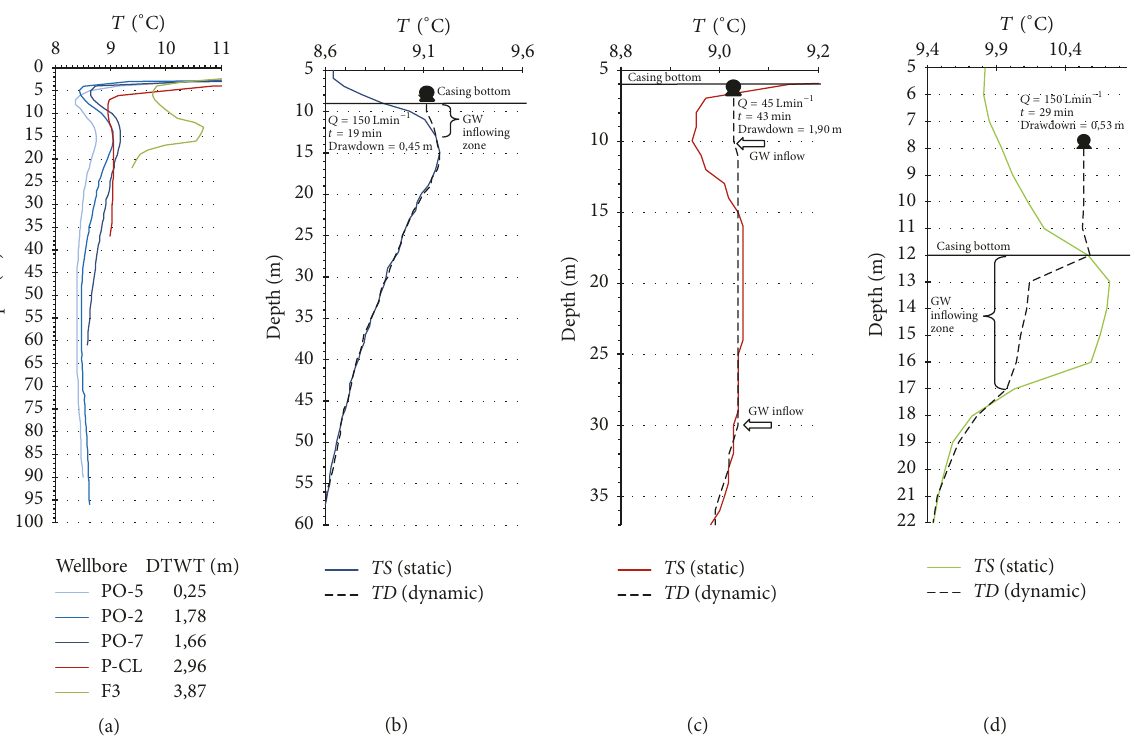
Figure 9: Temperature profiles in June 2016 for all wells under static conditions (a) and under static and dynamic conditions for wells PO-7 (b), P-Cl (c), and F3